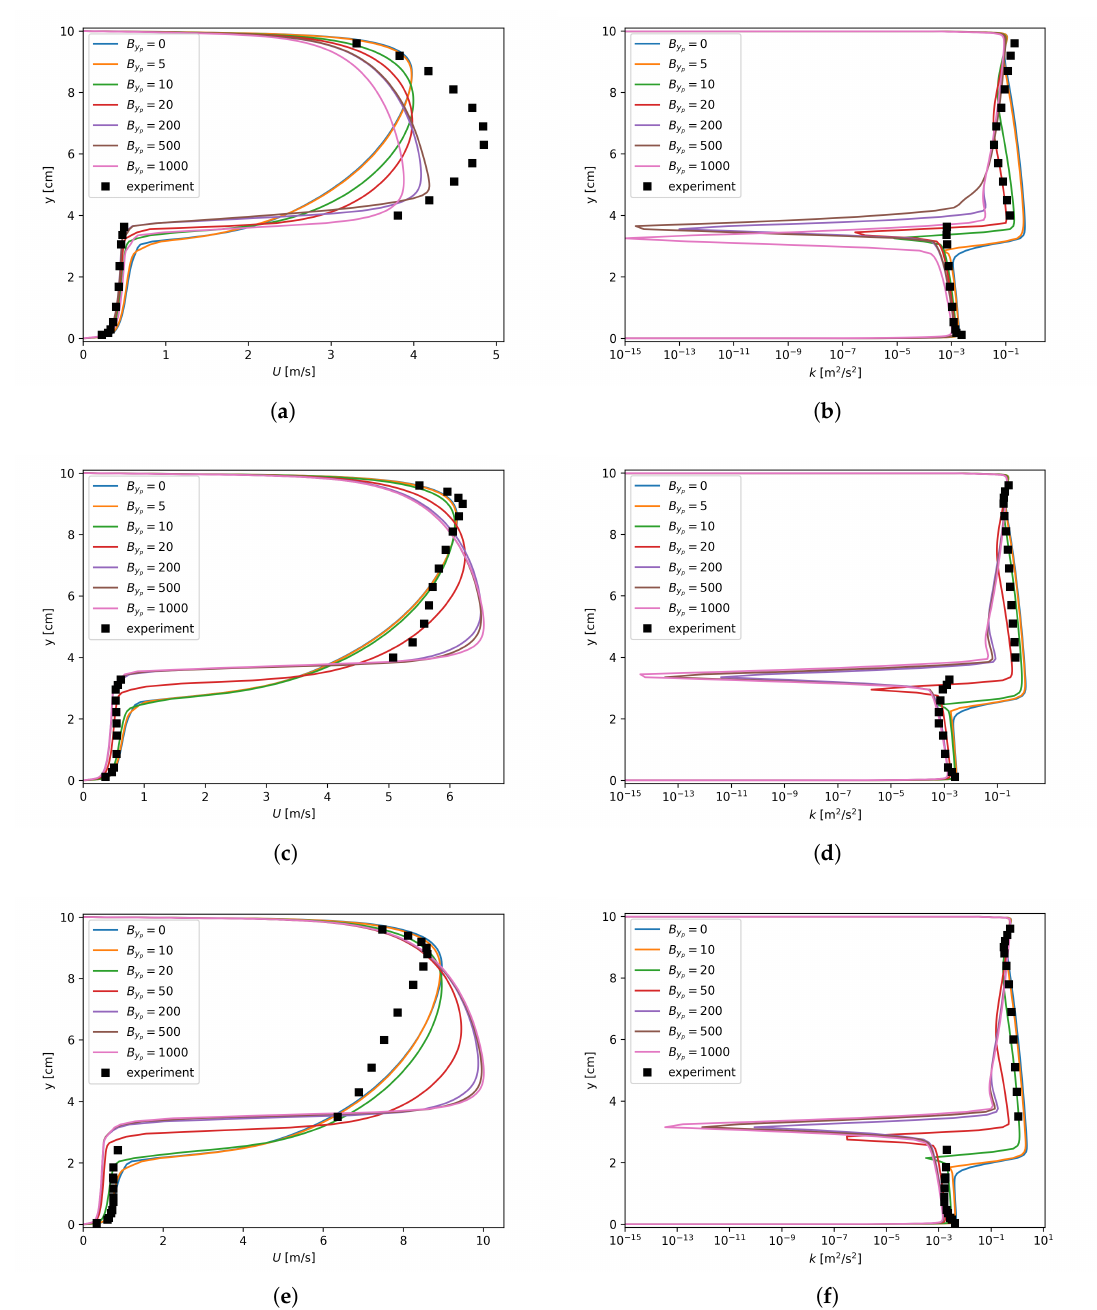
Figure A2. Axial velocity and turbulent kinetic energy dependency on B y axial velocity; ( b ) Run 250, k ; ( c ) Run 400, axial velocity; ( d ) Run 400, k ; ( e ) Run 600, axial velocity; ( f ) Run 600, k